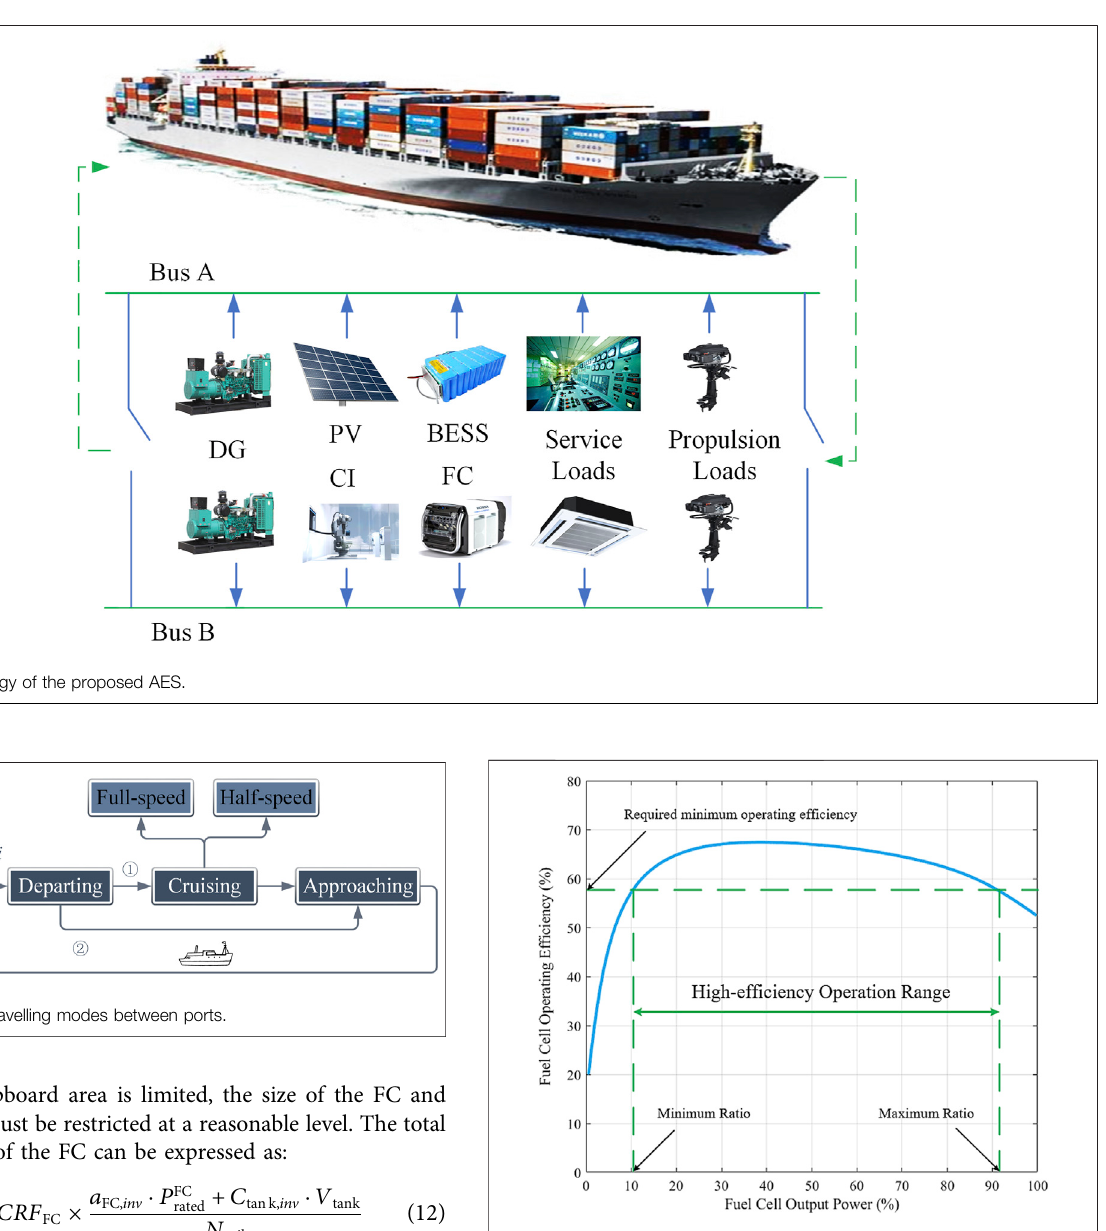
FIGURE 3 | The relationship between the output power and operation ef fi ciency of fuel